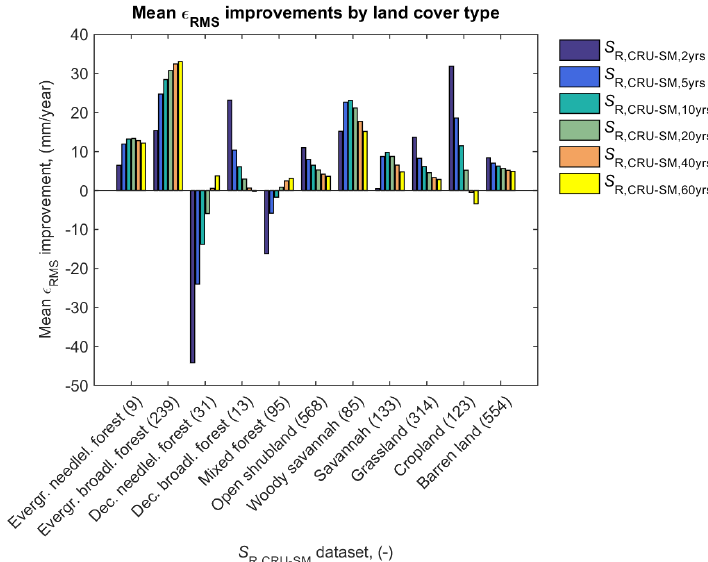
Figure 9. The mean ε RMS improvement in simulated monthly evaporation E (2003–2013) by implementing S R,CRU-SM ,L, yrs (based on P CRU and E SM ) instead of S R,STEAM (based on look-up table in Wang-Erlandsson et al., 2014) in the global hydrological model STEAM, where the satellite-based E SM was used as the benchmark for improvements (see methods described in Sect. 2.2). The improvements for root zone storage capacities with different return periods L 2–60 years (i.e. S R,CRU-SM,2yrs , S R,CRU-SM,5yrs , S R,CRU-SM,10yrs , S R,CRU-SM,20yrs , S R,CRU-SM,40yrs , and S R,CRU-SM,60yrs ) are shown for the different land cover types that have > 90% grid cell coverage. The number of represented grid cells are provided in the parenthesis following each land cover type label along the x